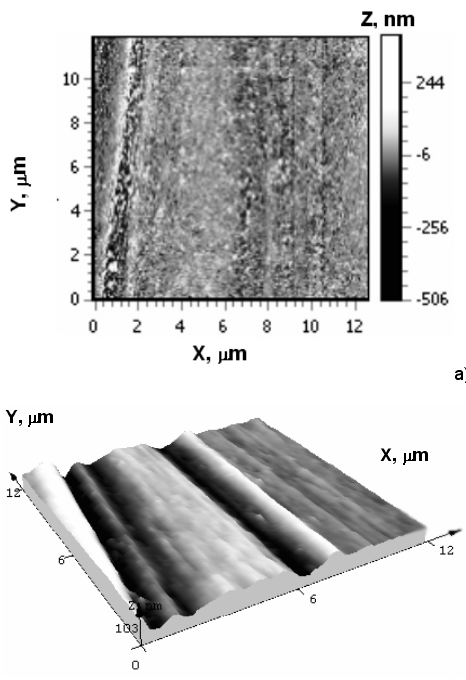
Figure 8. Atomic force microscopy view of Cu on PA surface: 2D view of lateral forces microscopy (a) and 3D topography view (b). PA was chalcogenized 0.25 h at the temperature of 10 o C in 0.025 mol dm -3 K